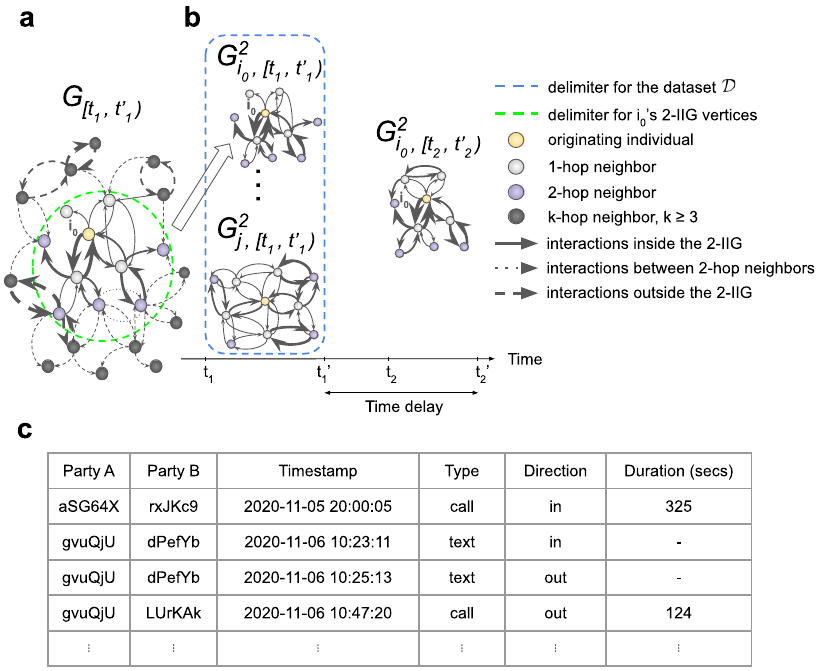
Fig. 1 Setup of the behavioral pro fi ling attack. a An example of a 2-IIG is highlighted in the larger graph it comes from. The vertices of the 2-IIG (inside the dashed green circle) are respectively the originating individual (in yellow), 1-hop neighbors (in gray), and the 2-hop neighbors (in purple). In solid lines are the edges that are part of the 2-IIG: all the edges between the originating and 1-hop neighbors; between the 1-hop neighbors; and between 1-hop and 2-hop neighbors, but excluding those between 2-hop neighbors (dotted lines). Dashed lines are all the other edges. For simplicity, all edges are shown as a single directed edge of thickness proportional to the total number of interactions. b The data available to the attacker consist of (left) 2-IIGs coming from the time period ½ t 1 ; t 0 Þ , usually as part of an anonymized dataset, and (right) auxiliary 2-IIG data about a target individual A 1 ( G 2 i ). While we here display auxiliary data coming from a later period in time, our attack applies equally to cases where the auxiliary data comes 0 ; ½ t 2 ; t 0 2 Þ from an earlier time period. c An example of mobile phone interaction data. Each interaction contains the pseudonyms of the parties A and B, timestamp, type of interactions, direction (equal to “ out ” if A initiated it, “ in ” otherwise), and the duration for calls. In this example, the